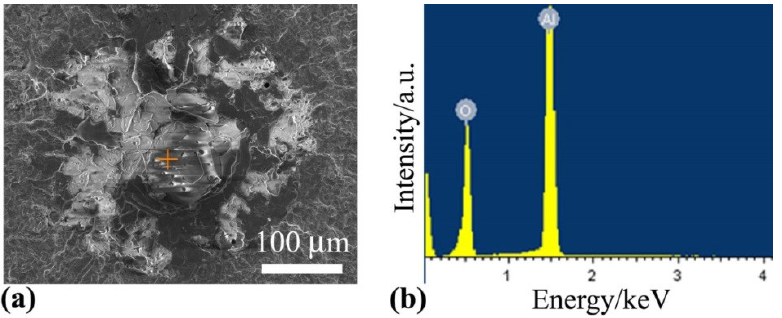
Figure 8. Analysis of composition of the inclusion in crack initiation region in Figure 6d. ( a ) SEM image of the crack initiation region. The symbol “+” denotes the location analyzed by EDS; ( b ) result by EDS.